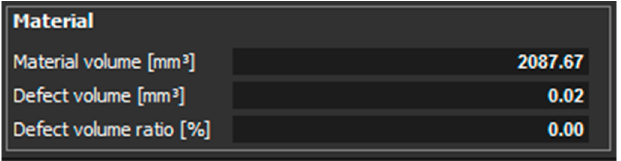
Figure 17. Measured values for the sample with thickness of 3 mm, which was oriented in Z.